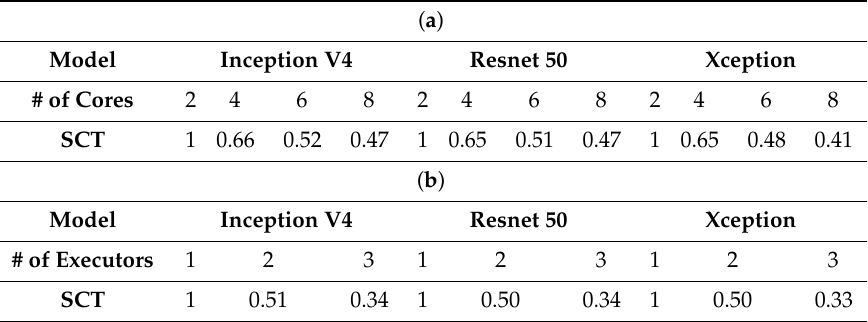
Table 5. E ff ect of the number of cores on the SCT of each CNN model.